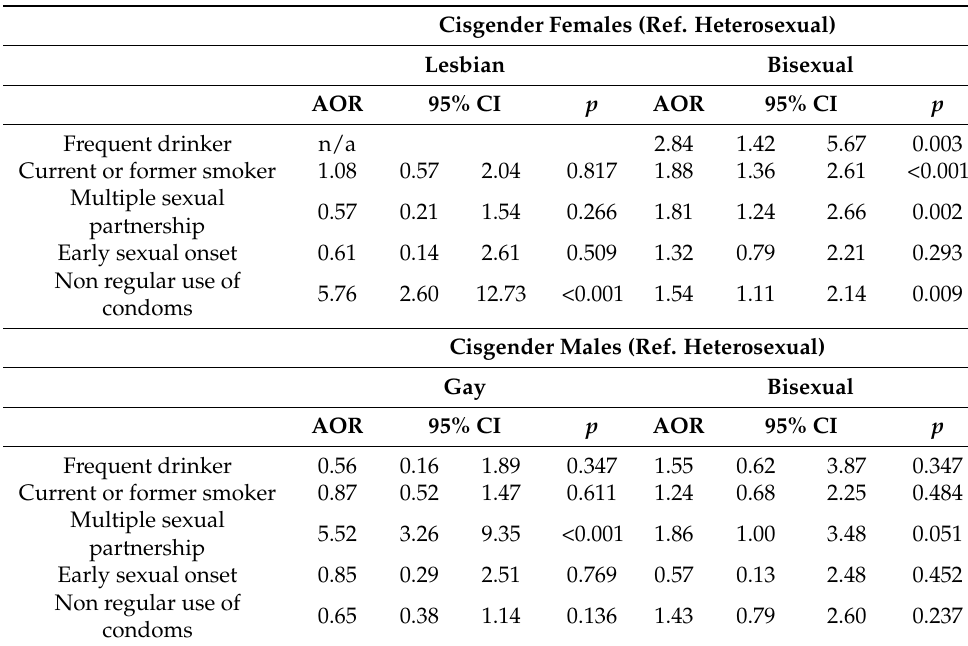
Table 3. Multinomial logistic regression. The effect of sexual orientation on the adoption of risk behaviours in the study